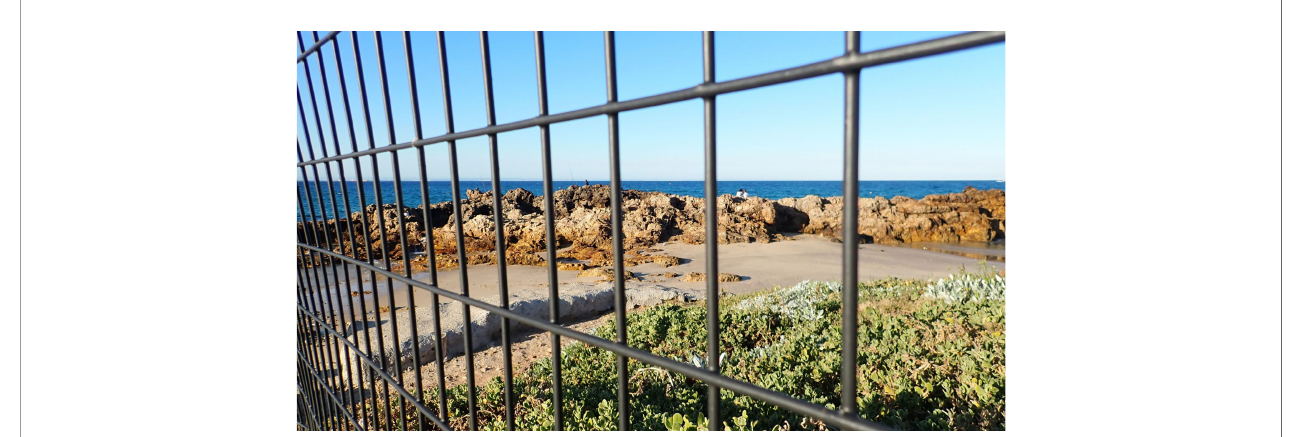
FIGURE 2 | Photograph of a beach in Algoa Bay with a fence in front of it. Many areas are now fenced off for people to use, often with